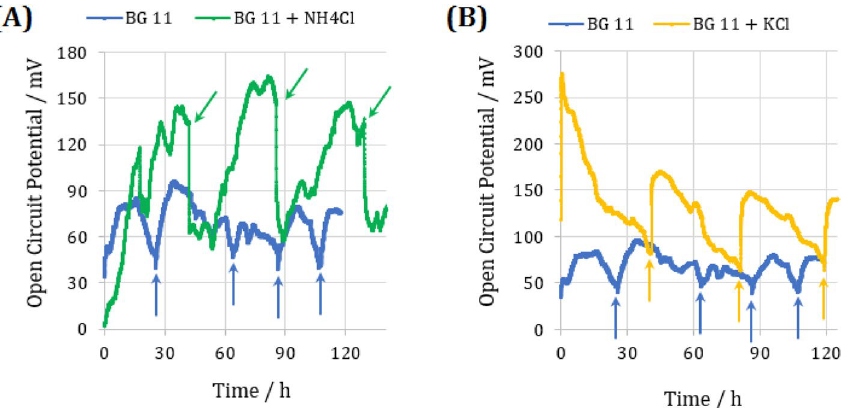
Figure 4. The open circuit potential (OCP) evolution of three used suspensions for microbial enrichment. ( A ) Synechocystis + BG-11 and Synechocystis + BG-11 + 40 mM NH 4 Cl, ( B ) Synechocystis + BG-11 and Synechocystis + BG-11 + 50 mM